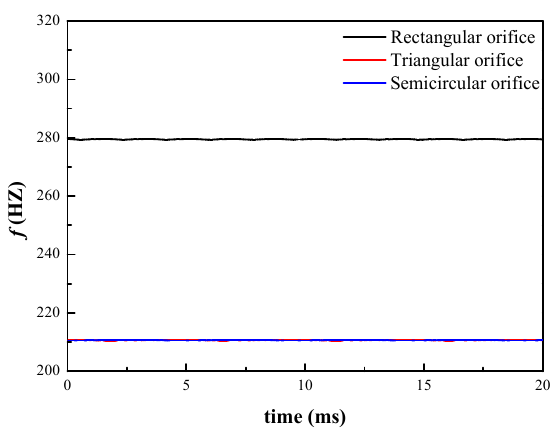
Figure 24. Reversing frequencies of different orifice shapes.